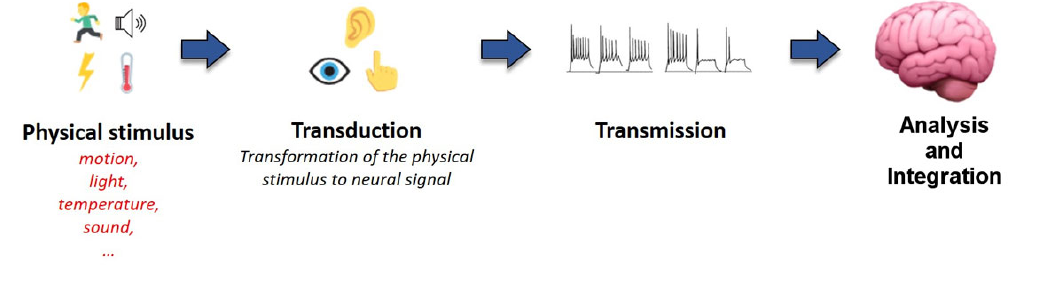
Figure 1: Sensory systems. The process begins with a physical stimulus (e.g., physical motion, light, temperature, sound) which is detected by a specialized sensory receptor (e.g., inner ear, retina, nerve endings). This stimulus is transduced to neural electrical currents which are transmitted to the central nervous system through specific pathways. The sensory stimulus can be finally interpreted as it reaches the brain .